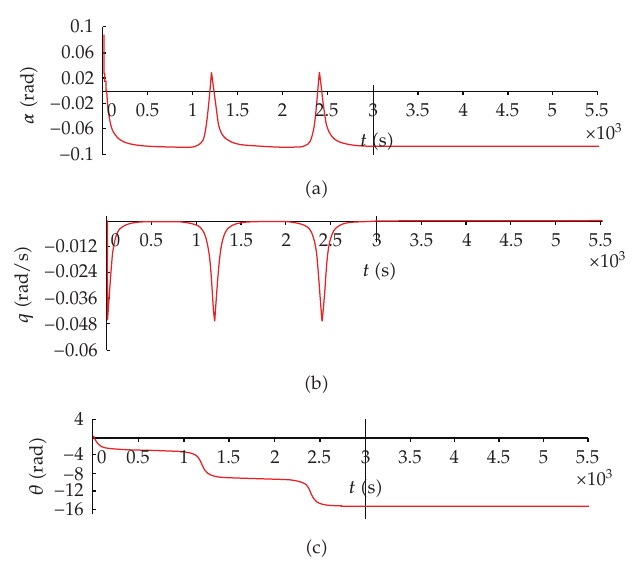
(cid:6) (cid:7) − 0 . 04678 (cid:5) rad (cid:6) (cid:7) − 2 . 681 ◦ after 3000 (cid:5) s (cid:6) e to δ e